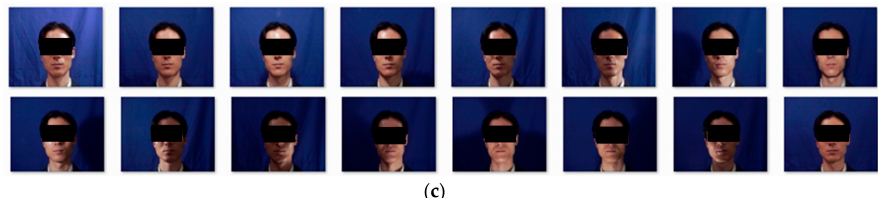
Figure 10. Examples of face databases for experiments: ( a ) examples in the E-face database; ( b ) examples in the XM2VTS face database; and ( c ) examples in the PF07 database with frontal face pose, neutral face expression, and 16 illumination variations.